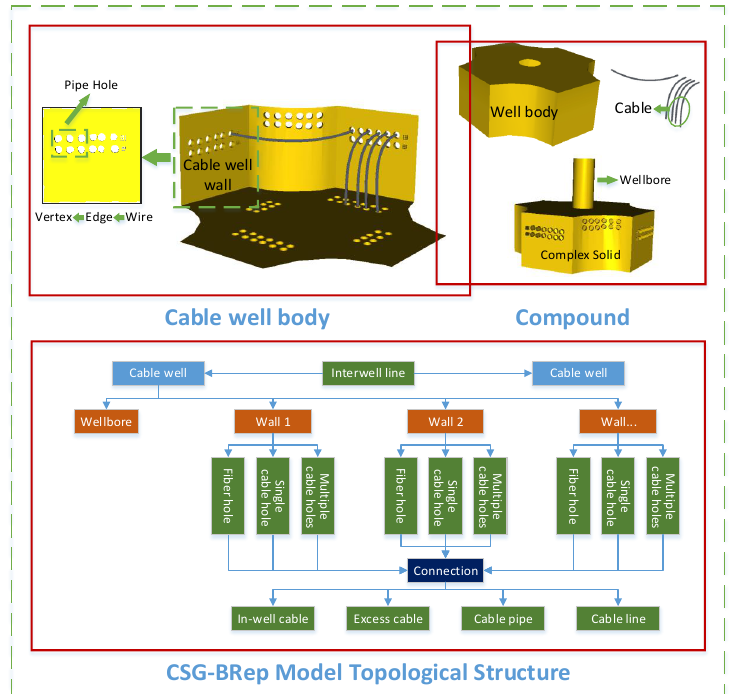
Figure 11. Topological structure of the underground cable well model.